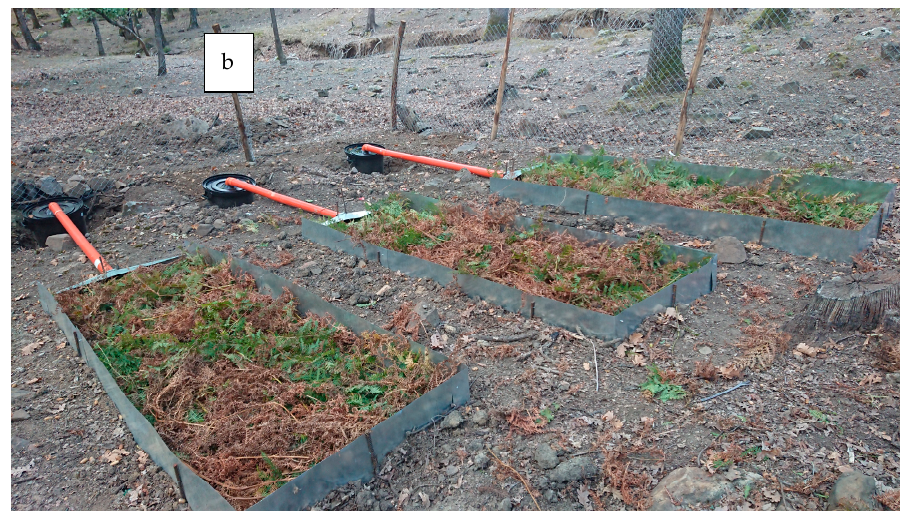
Figure A1. Prescribed fire operations ( a ) and mulching application ( b ) in the experimental site (Samo, Calabria, Southern Italy).